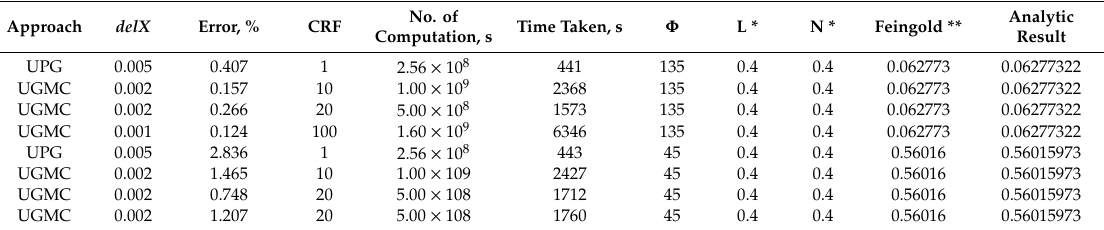
Table 4. Computation of view factor, F 12-34 using UPG and UGMC routine, uniform reflectance. (Figure 4a,b refers).